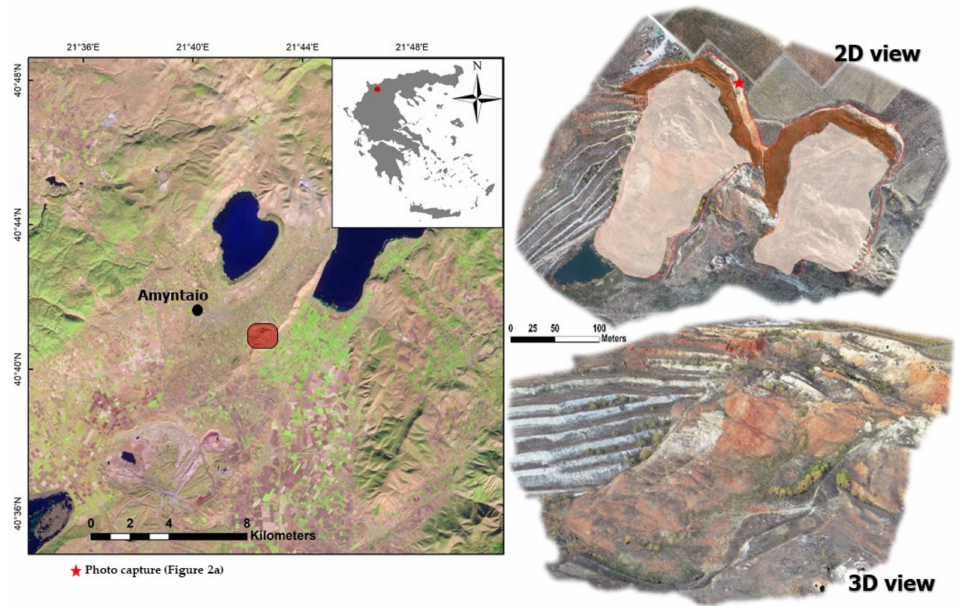
Figure 1. Location of the area under investigation in north-western Greece. The red box indicates the study site in the area of Amyntaio. 2D perspective with the created reference data overlaid (dark brown: scarp, light brown: depletion) and 3D view of the slope